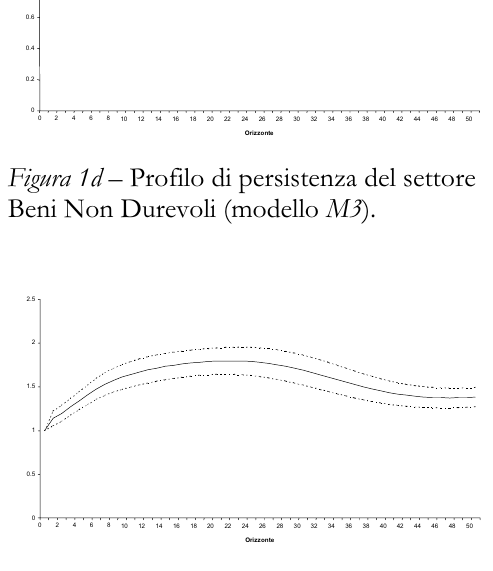
Figura 1e – Profilo di persistenza del settore Costruzioni (modello M3 ).